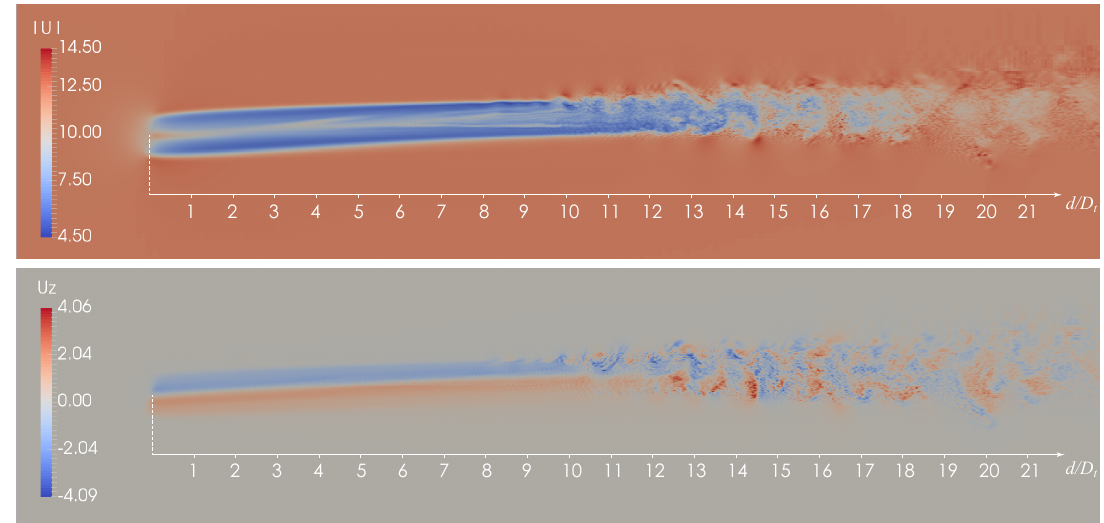
Figure 4. Velocity color plots for the Actuator Line Model (ALM), top views. Wind blows eastwards, while rotor axis is rotated 15 ◦ north with respect to West direction (left-hand side of the pictures). ( Top ) Magnitude of flow velocity for the case ALM 22 ; ( Bottom ) Vertical component of flow velocity for the case ALM 22 : the two opposite contributions of the ascending and descending blade are relevant and evident. The downstream distance normalized with the rotor diameter is reported on the x